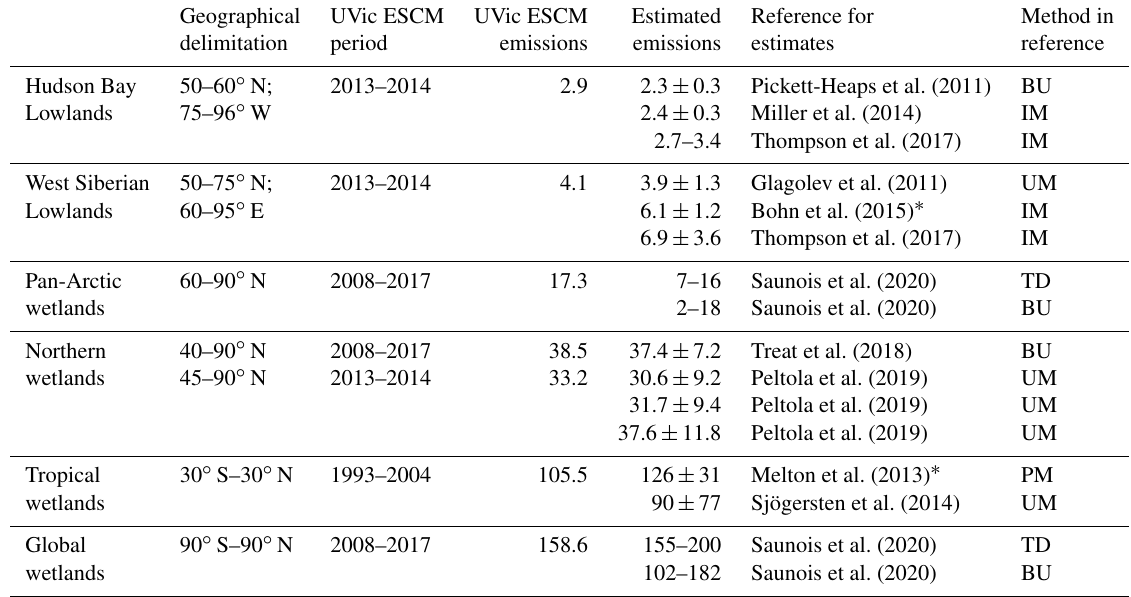
∗ These reported estimates are model ensemble means. For the West Siberian Lowlands, the range between the inverse models is 3.1–9.8TgCH al., 2015). For tropical wetlands, the range between the process-based models is 85–184TgCH 4 yr − 1 (Melton et al.,